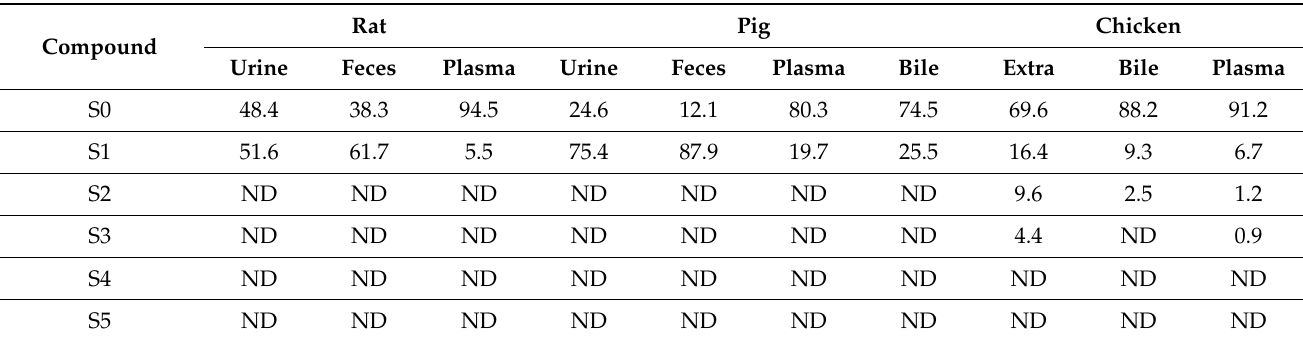
Table 3. The percentage of the individual metabolites compared with the total concentration of SMZ-related within 12 h after dosing (%).